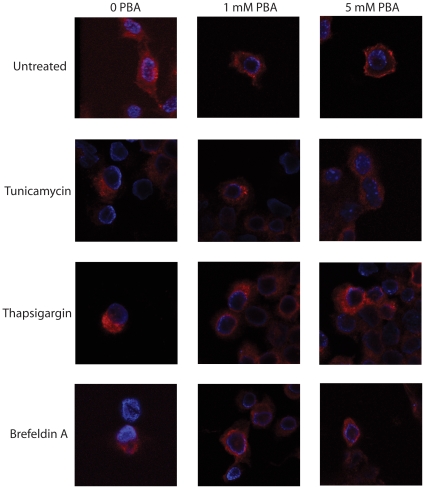
PBA stimulates trafficking out of the intracellular organelles.NAG cells were untreated, or treated with thapsigargin (0.25 µM), tunicamycin (5 µg/ml), or brefeldin A (5 µg/ml) in the presence or absence of PBA for 24 hours. The cells were stained with the VP16 antibody (red) and counterstained with Hoescht (blue) to localize the nuclei. Confocal imaging was performed to examine protein localization. In untreated cells, APPGV16 localized throughout the cytosol with slight peri-nuclear aggregations observed, consistent with the ER localization of de novo membrane proteins. PBA treatment promoted migration of APPGV16 toward the plasma membrane (top row). In tunicamycin, thapsigargin and brefeldin A treated cells, APPGV16 localized to the ER-like perinuclear region (left column, lower three images). Upon the addition of 1 mM or 5 mM PBA, APPGV16 localization shifted away from the nucleus in tunicamycin and thapsigargin treated NAG cells. In contrast, PBA had no effect upon the localization of APPGV16 in the brefeldin A treated cells.